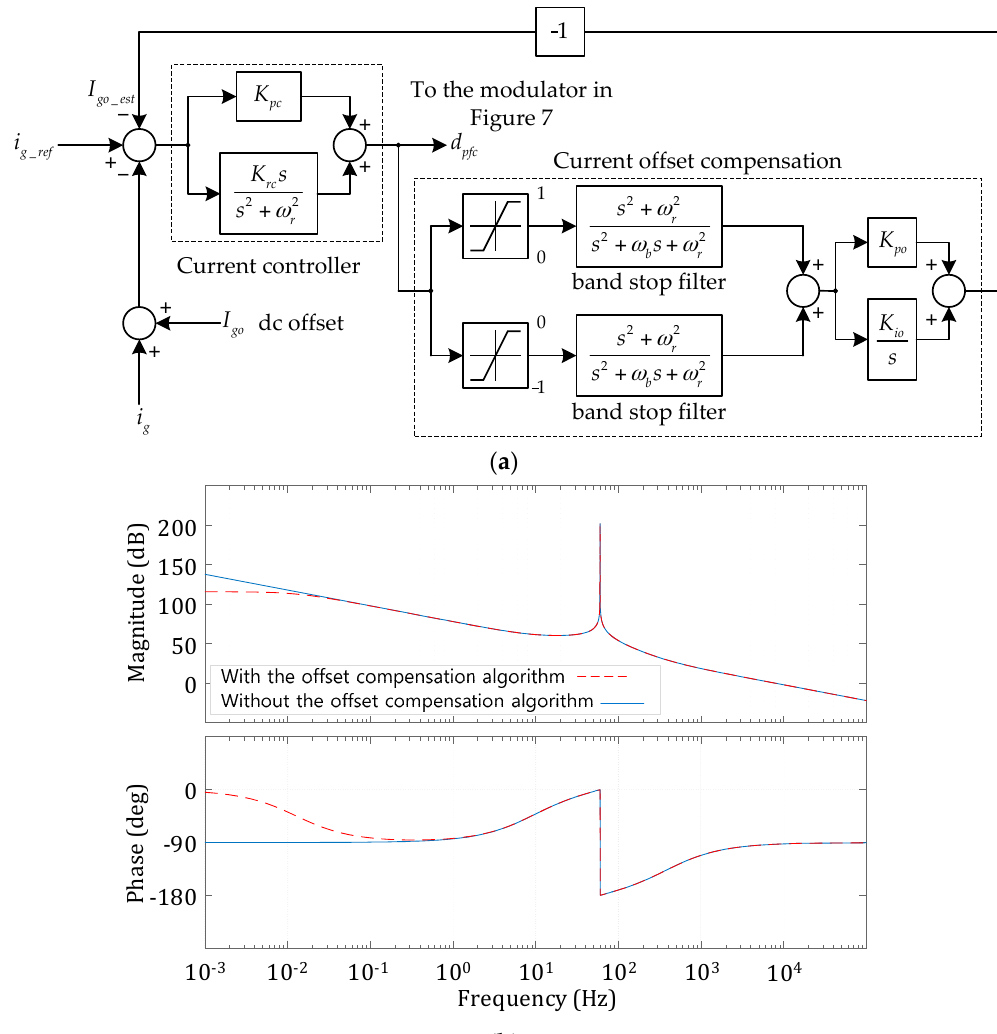
Figure 12. Proposed control structure and open-loop gain. ( a ) Current control structure with the offset compensation algorithm ( b ) open-loop gain of the control loop.